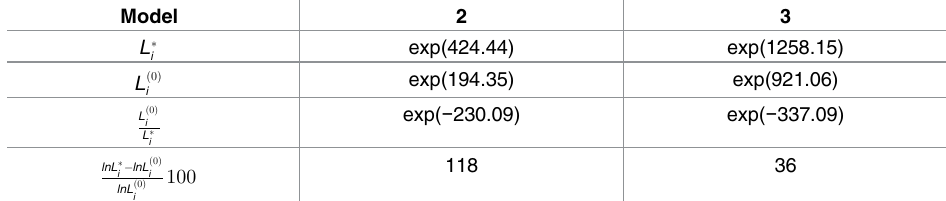
Table 13. Efficiency’s gain due to modeling industry-specific tendency